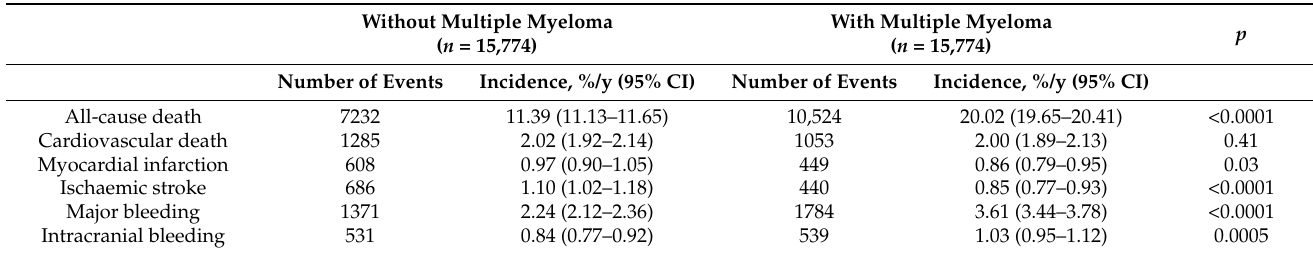
Table 3. Incident outcomes in the matched population